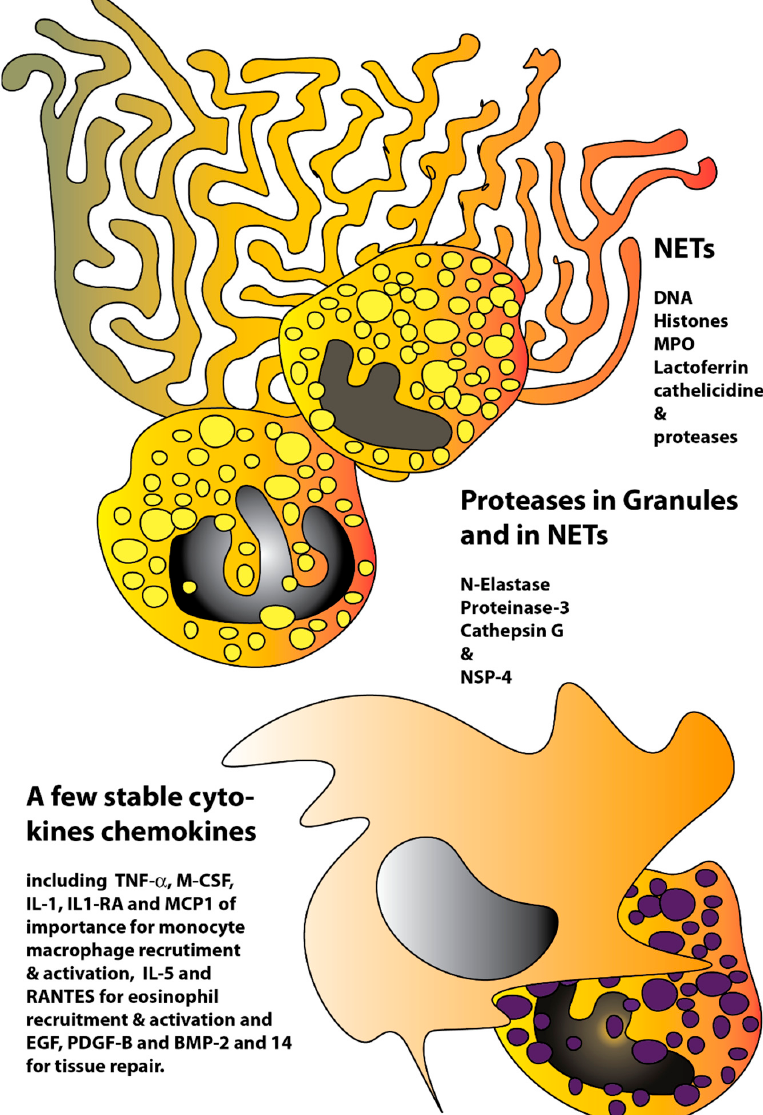
Figure 4. Schematic drawing of the site of infection involving neutrophils, neutrophil extracellular traps and the recruitment of monocytes/macrophages, neutrophils and possibly eosinophils. The picture shows two activated neutrophils with a neutrophil extracellular trap and an incoming monocyte-macrophage and an eosinophil. The neutrophil traps consist of neutrophil chromosomal and mitochondrial DNA to which histones and various neutrophil granule proteins are attached. In these traps, myeloperoxidase (MPO), lactoferrin, the antibacterial peptides including cathelicidine and defensins, as well as the various serine proteases have been found. The high resistance to cleavage of a few cytokines, chemokines and chemokine receptors observed (from Figure 2) indicate that these are particularly stable in order not to hamper the influx of monocytes/macrophages and possibly also eosinophils to assist the neutrophils to clear the infection.